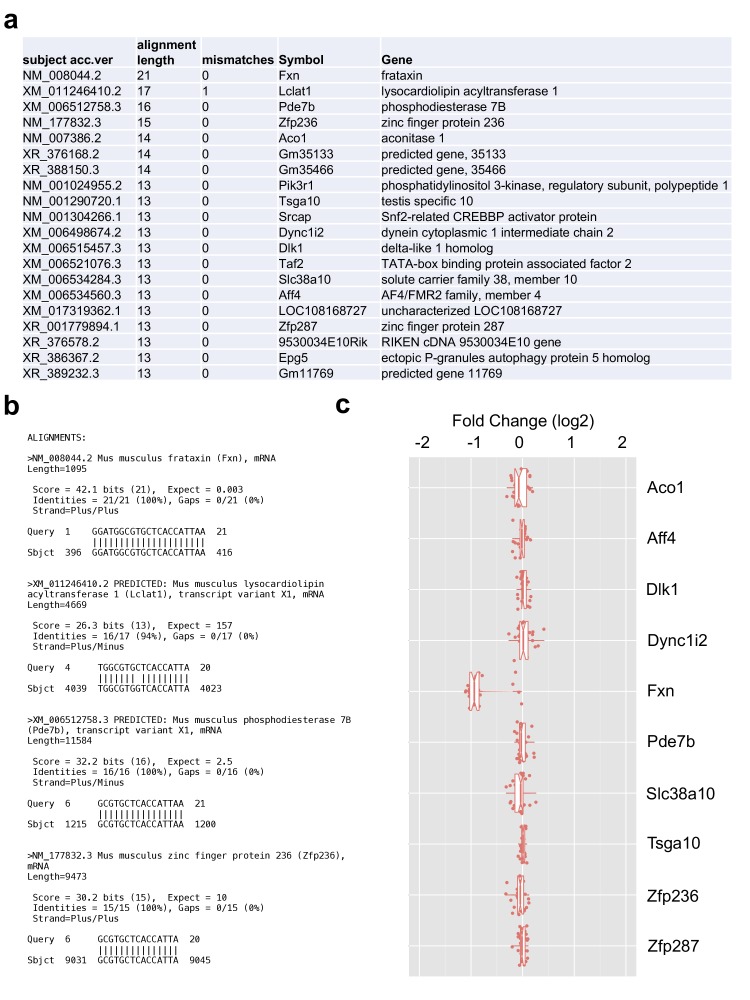
Validation of shRNA off-target effects.(a) Potential putative targets of the shRNA sequence (GGATGGCGTGCTCACCATTAA) in the whole mouse genome transcripts identified utilizing the BLASTN program. (b) Example alignments of top four hits showing Fxn gene as top hit with all 21 base pair matched as expected along with other potential targets having 16 to 13 base pair matches. (c) Box plots showing gene expression levels of all the potential target genes present in our microarray data (see Figure 7) after induction of the shRNA. It is important to know that not all the potential targets genes had a probe on the Illumina array, hence the plot only shows ten genes. Fxn was the only gene showing significant down-regulation when compared to all other potential targets genes, suggesting the absence of significant off-target effects.